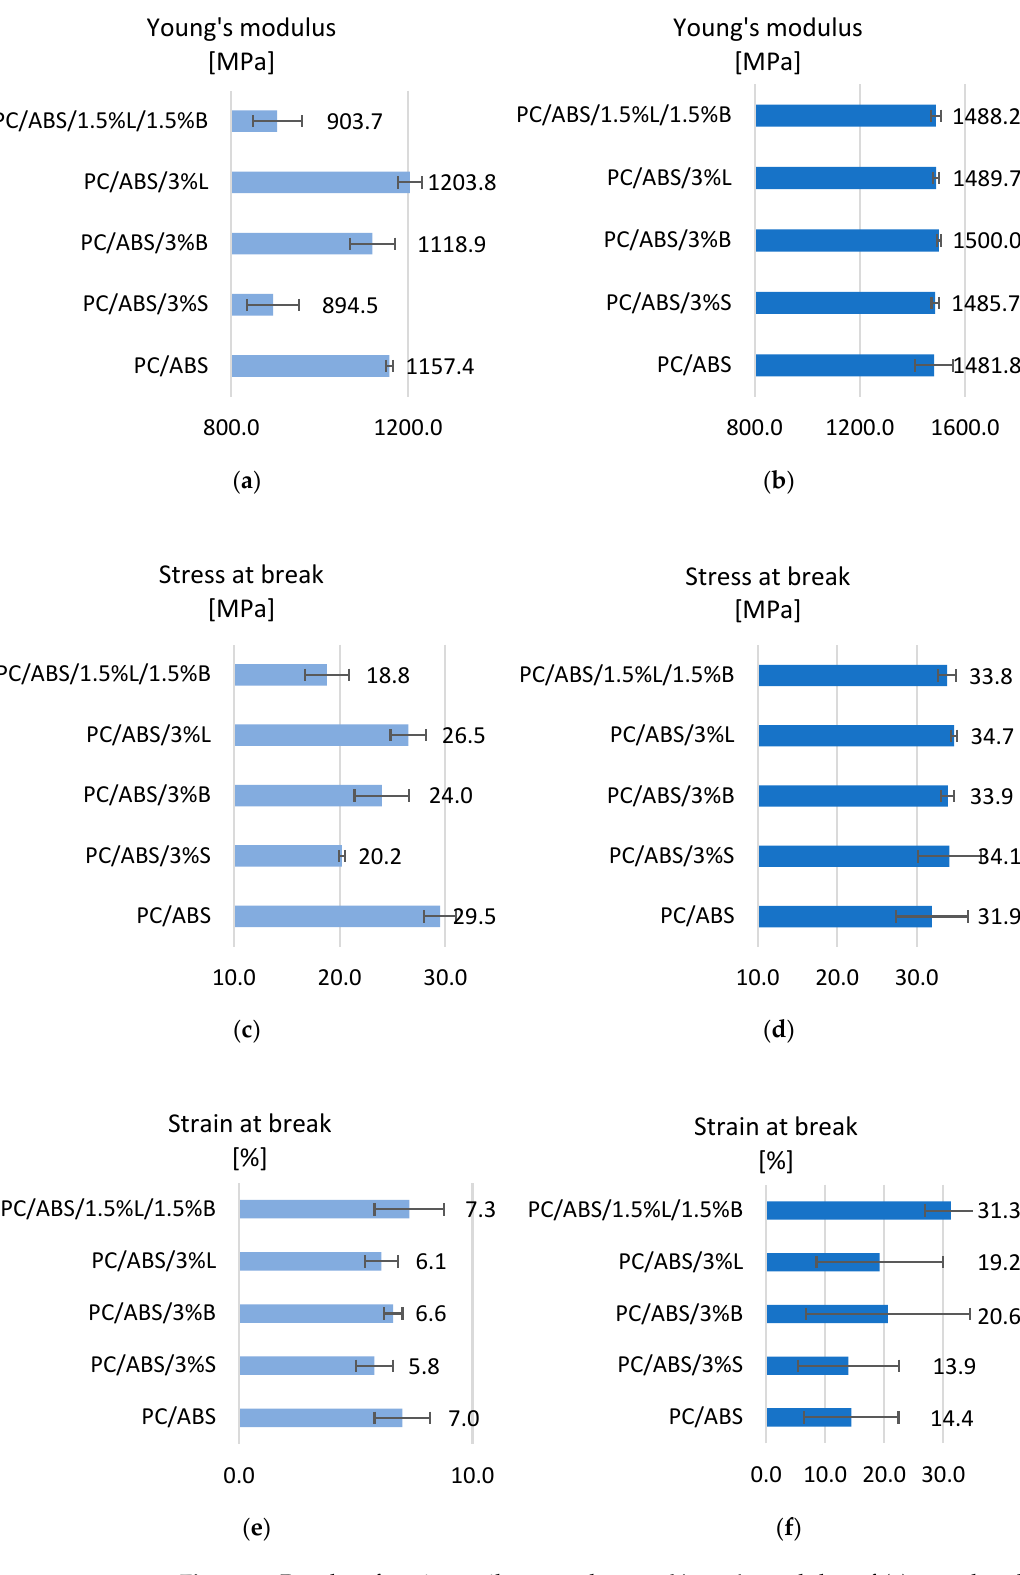
Figure 6. Results of static tensile strength tests: Young’s modulus of ( a ) samples obtained by 3D printing and ( b ) samples obtained by injection molding; stress at break of ( c ) samples obtained by 3D printing and ( d ) samples obtained by injection molding; strain at break of ( e ) samples obtained by 3D printing and ( f ) samples obtained by injection molding.